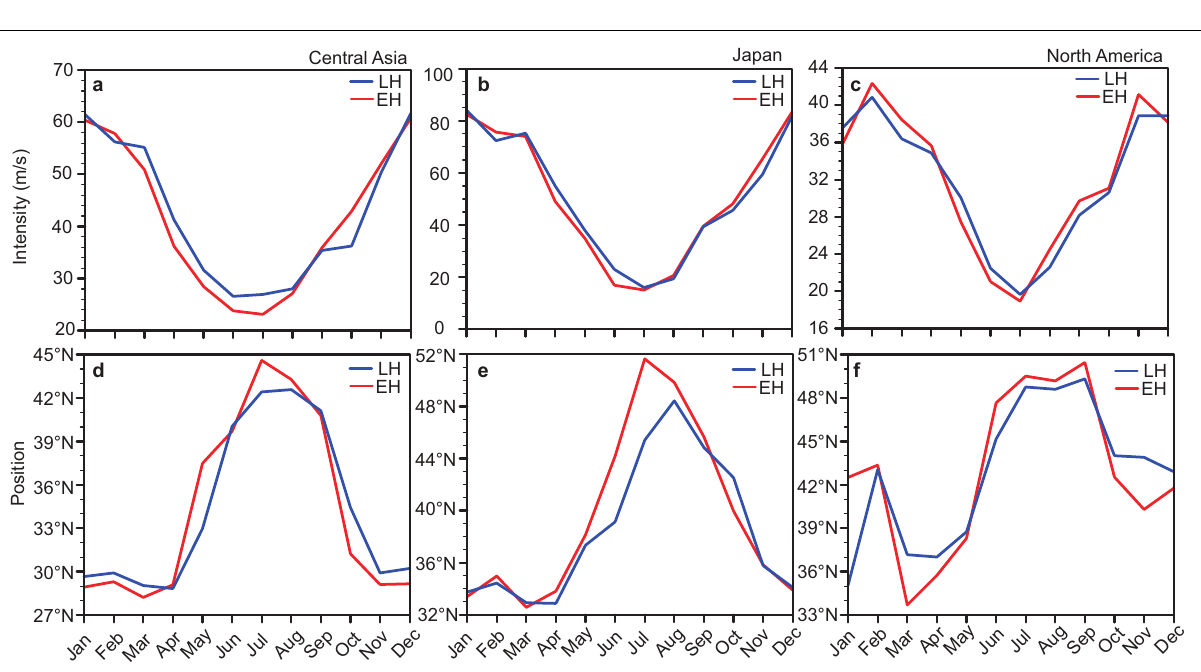
Frontiers in Earth Science |